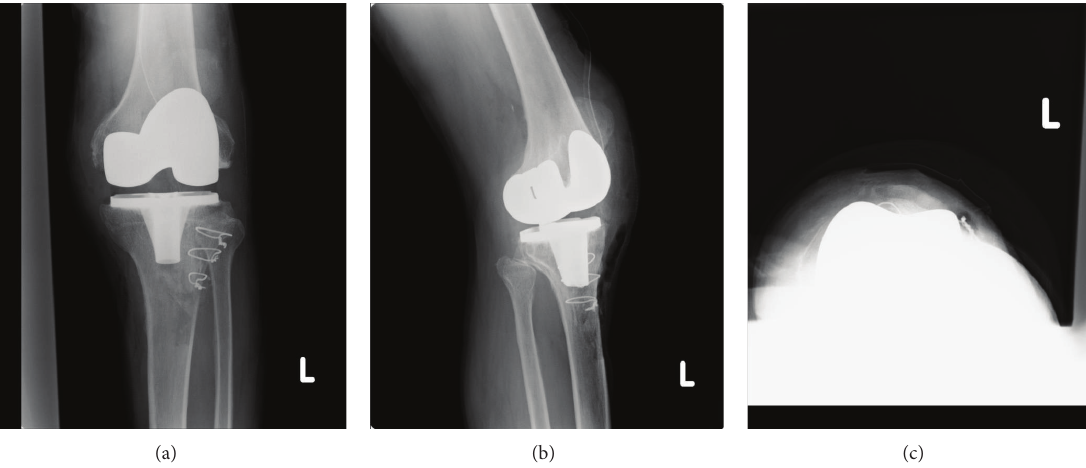
Figure 4: Postoperative radiographs: anteroposterior view (a), lateral view (b), and skyline view (c) of left